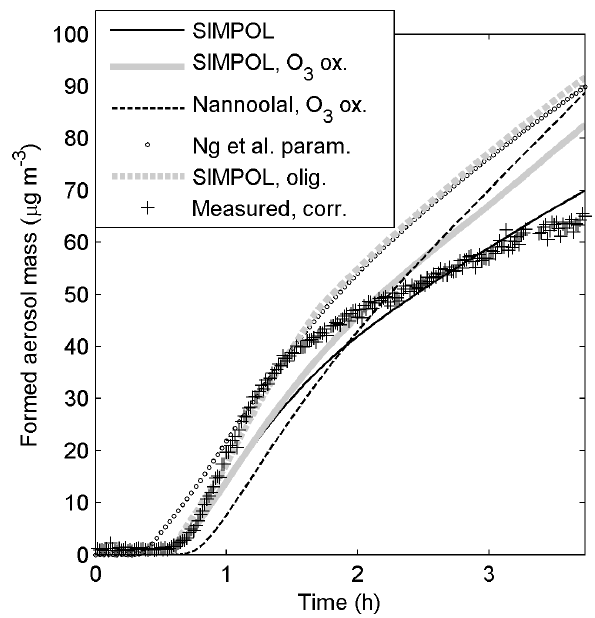
Figure 16. Modelled and measured (wall-loss-corrected) SOA mass during the m -xylene oxidation experiment by Nordin et al. (2013). The model results are from simulations without wall losses to the chamber walls. The simulations were performed with the SIMPOL vapour pressure method without or with heteroge- neous reactions between O 3 and the unsaturated organic compounds = 10 − 16 molecules − 1 cm 3 s − 1 and D = 10 − 8 cm 2 s − 1 ) , (k O 0 , O 3 3 the Nannoolal vapour pressure method and heterogeneous reac- tions between O 3 and the unsaturated organic compounds, the semi- empirical parameterizations from Ng et al. (2007), and the SIM- POL vapour pressure method and peroxyhemiacetal and hemiacetal dimer formation ( k f = 10 − 22 molecules − 1 cm 3 s − 1